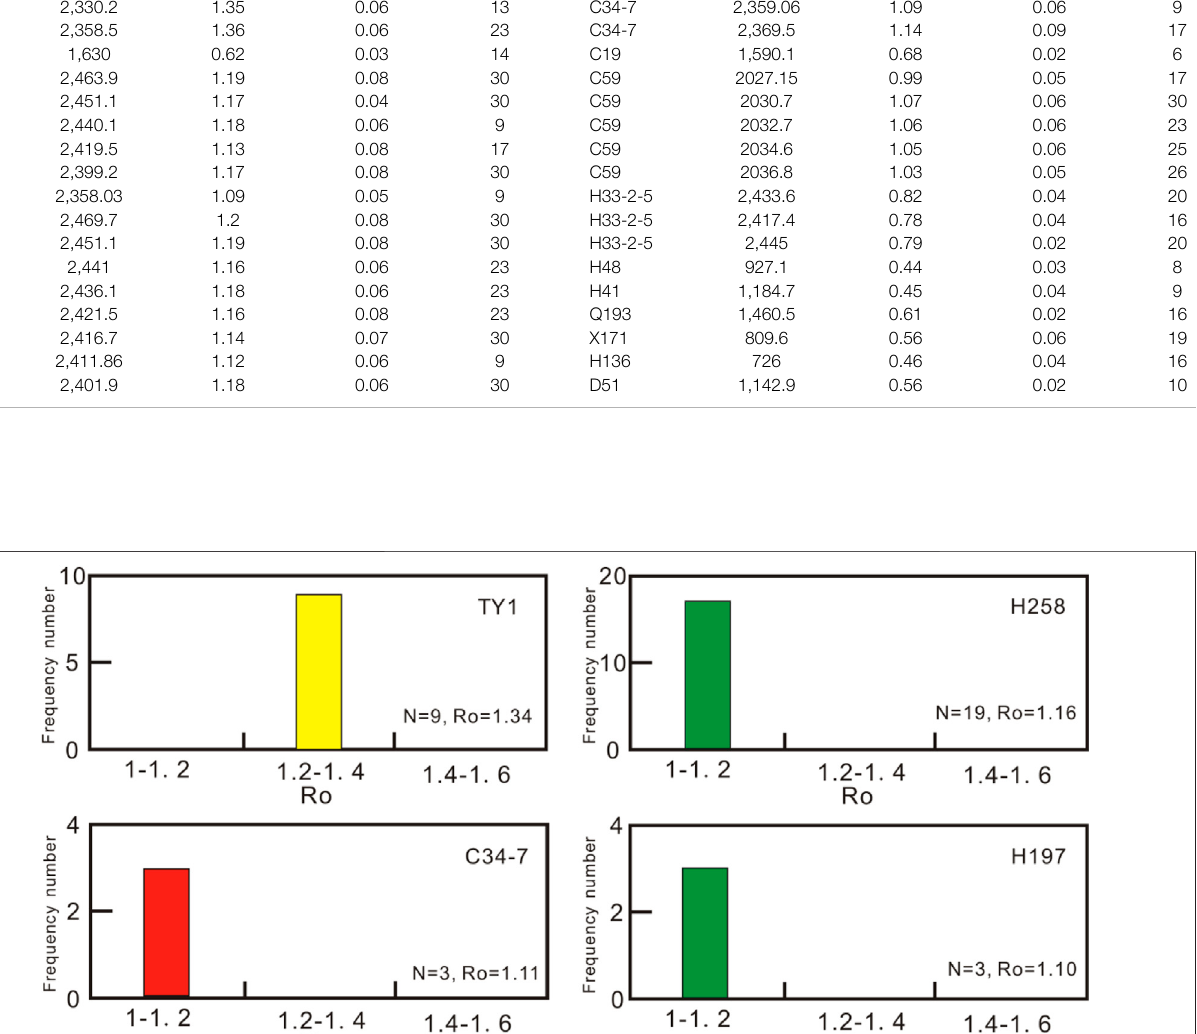
Frontiers in Earth Science |